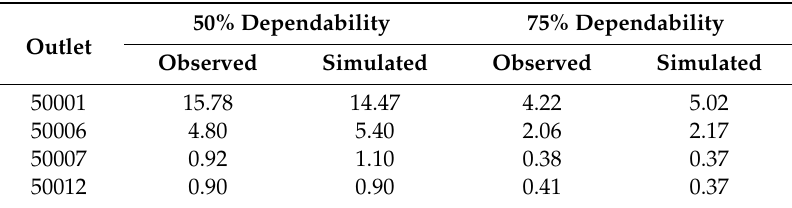
Table 3. Comparison between 50% and 75% dependability river flow values evaluated from observed and simulated flow-duration curves for each outlet.